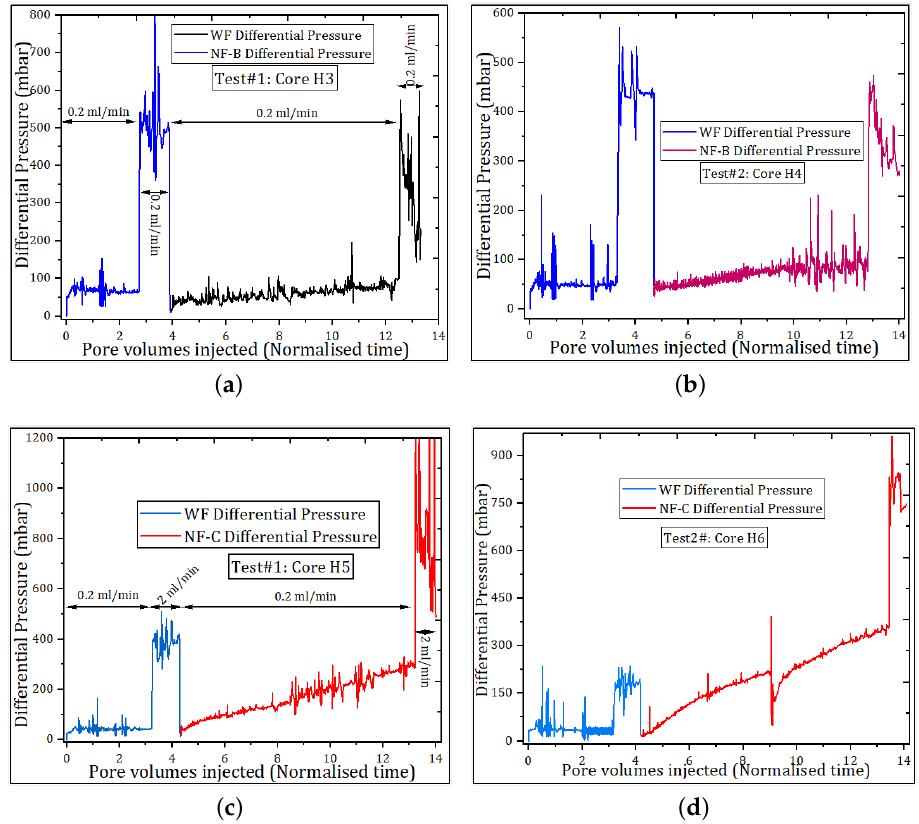
Figure 10. Pressure profiles for water flood (WF) and nanofluid flood oil recovery. ( a ) Test #1: Nanofluid “NF-B” injection showing little effect on water flood pressure; ( b ) In repeated Test #2, the pressure shows a slight increase compared to WF pressure; ( c ) Test #1, the pressure gradually increases with nanofluid “NF-C” and is higher than WF pressure; and ( d ) Similar behavior is observed in Test